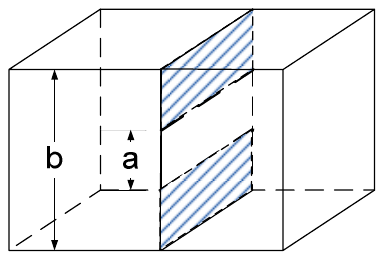
Fig. 6 Illustration of a slot in the rectangular